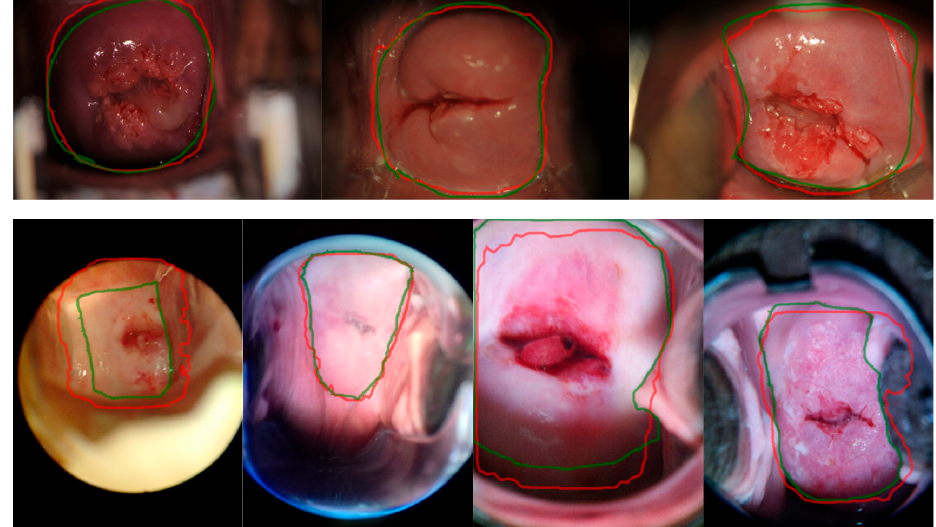
Figure 7. Segmentation examples of Mask X R-CNN trained with A + C _ box . Top row: images from dataset A. Bottom row: images from dataset C. The green line denotes the ground truth boundaries, the red line indicates the automatic boundaries.